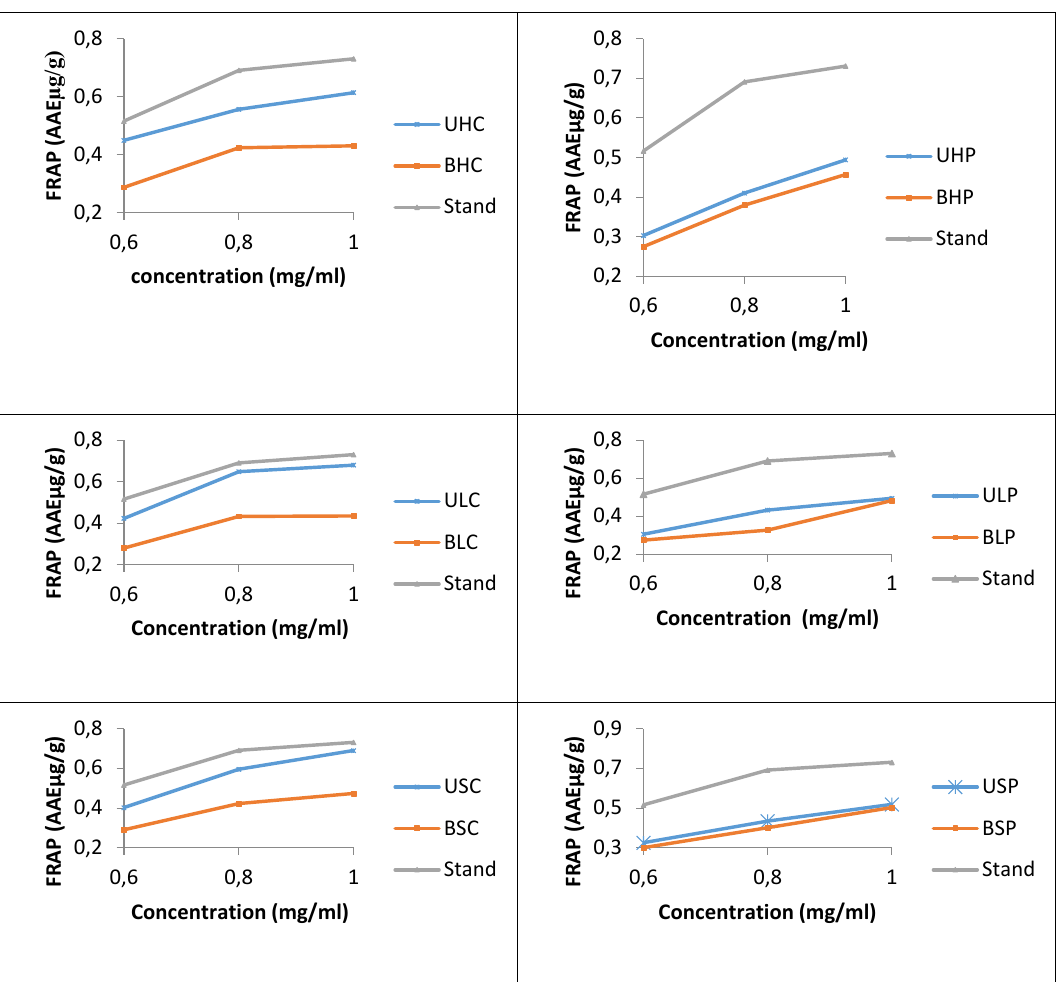
Figure 4: FRAP of cardaba banana and plantain flour UHC : Unblanched Cardaba at 70 ºC; BHC : Blanched Cardaba at 70 ºC UHP : Unblanched Plantain at 70 ºC; BHP : Blanched Plantain at 70 ºC ULC : Unblanched Cardaba at 50 ºC; BLC : Blanched Cardaba at 50 ºC ULP : Unblanched Plantain at 50 ºC; BLP : Blanched Plantain at 50 ºC USC : Unblanched Cardaba sun-dried; BSC : Blanched Cardaba sun-dried USP : Unblanched Plantain sun-dried; BSP : Blanched Plantain sun-dried